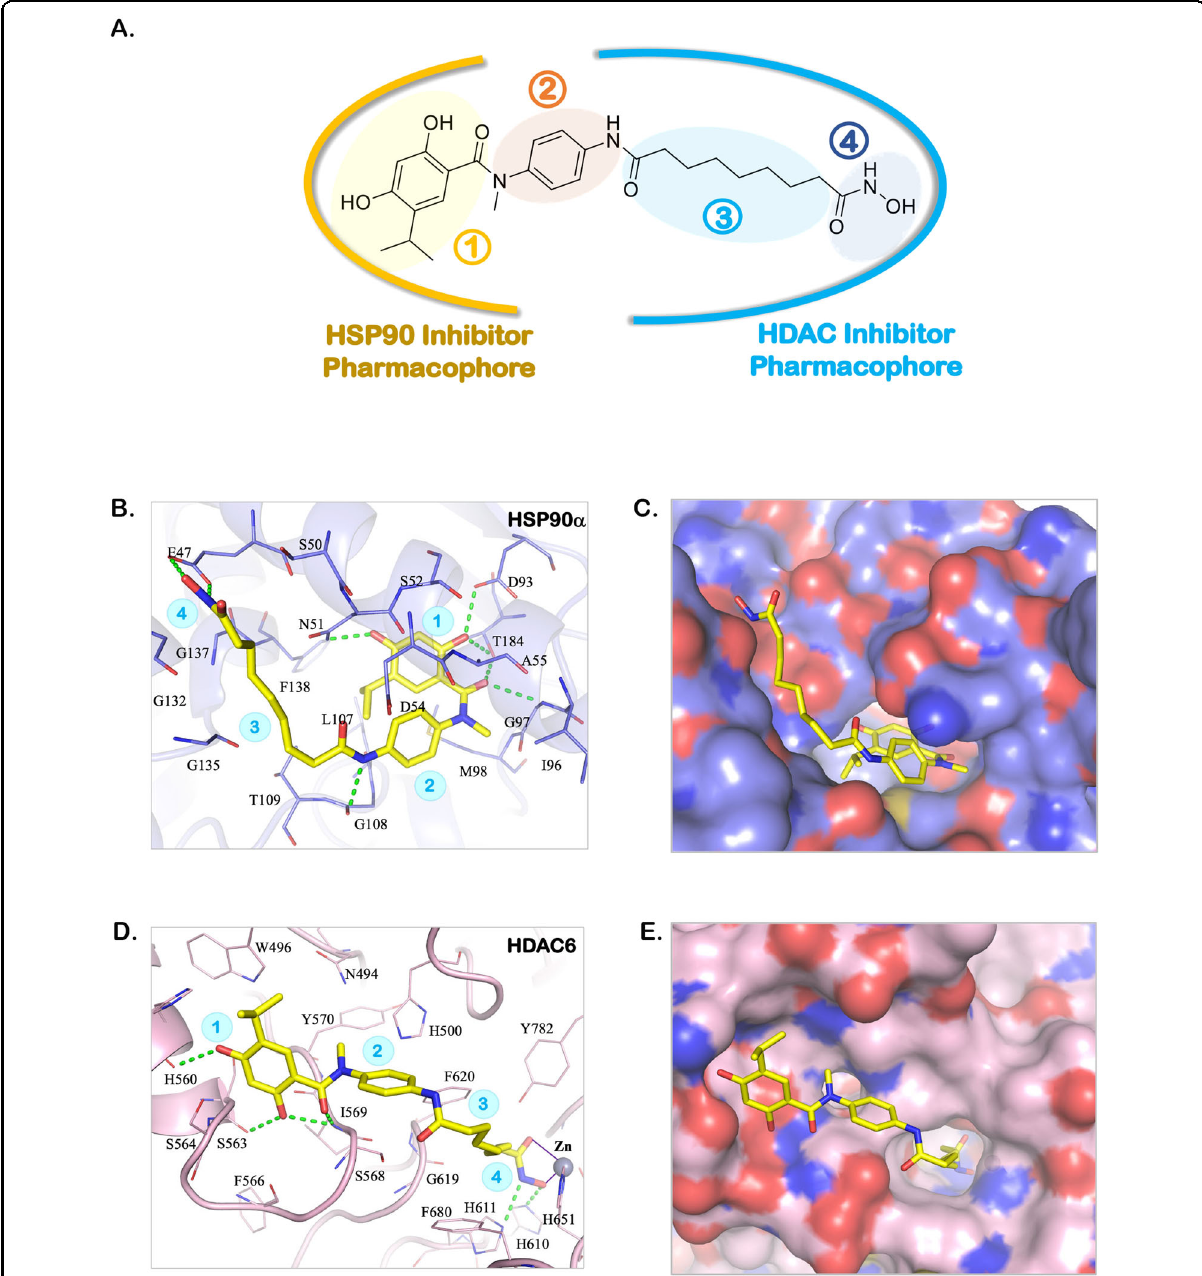
Fig. 1 The interaction between MPT0G449 and target proteins analyzes by molecular docking analysis. A MPT0G499 can be separated into four groups: 2,4-dihydroxy-5-isopropylbenzoyl (group 1), 4-amino- N -methylaniline (group 2), night-carbon chain (group 3) and hydroxamic acid (group 4). Groups 1 is HSP90 inhibitor pharmacophore, while groups 2, 3 and 4 are designed based on the HDAC inhibitor, SAHA. B The docking pose of MPT0G499 (yellow) in the HSP90 α binding site (purple). Hydrogen bonds are represented as a green dash line. Residues are labeled as shown. C The surface model shows that MPT0G499 enters the HSP90 α binding site. D The docking pose of MPT0G499 (yellow) in the HDAC6 binding site (purple). Hydrogen bonds are represented as a green dash line. Residues are labeled as shown. E The surface model shows that MPT0G499 enters the HDAC6 binding site.